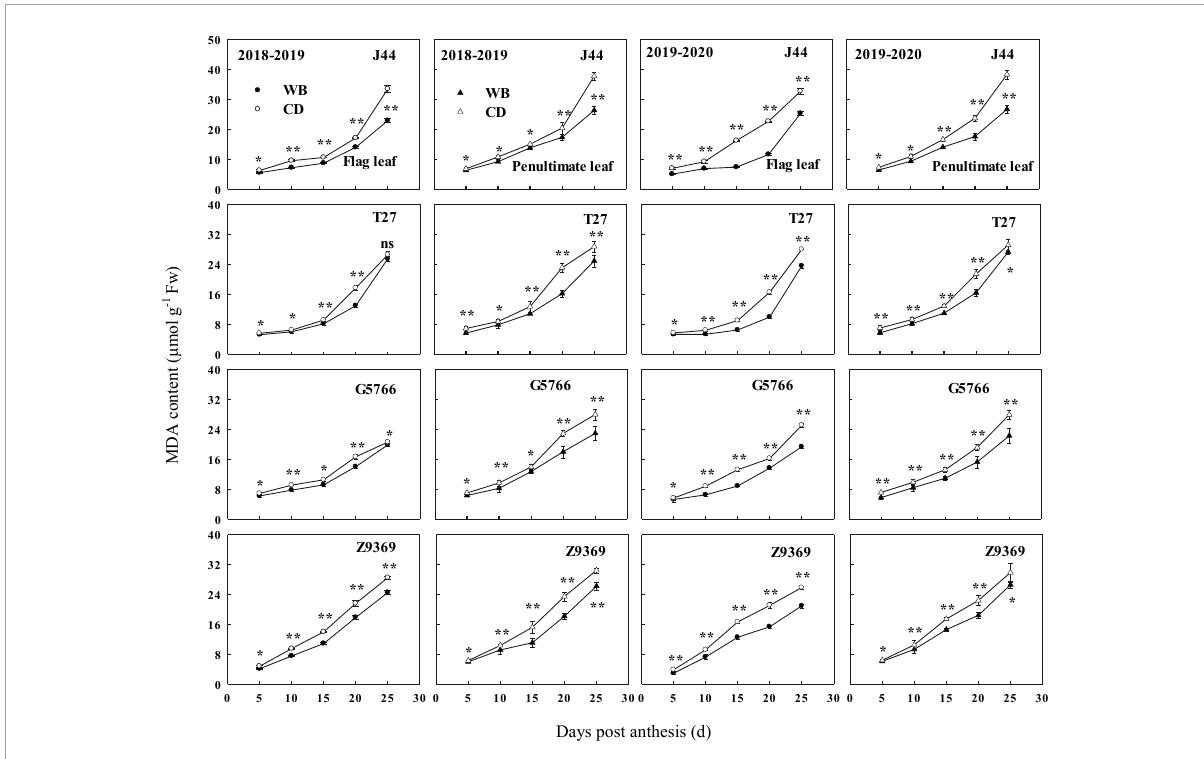
FIGURE10 Effects of sowing pattern on malondialdehyde (MDA) content of flag leaf and penultimate leaf of bread wheat. Values are means of three replicates per treatment. Vertical bars indicate standard error. * and **Indicate significant differences at P < 0.05 and P < 0.01 between the two sowing patterns at each measurement time, respectively. CD and WB denote the conventional drilling and wide belt sowing pattern, respectively.